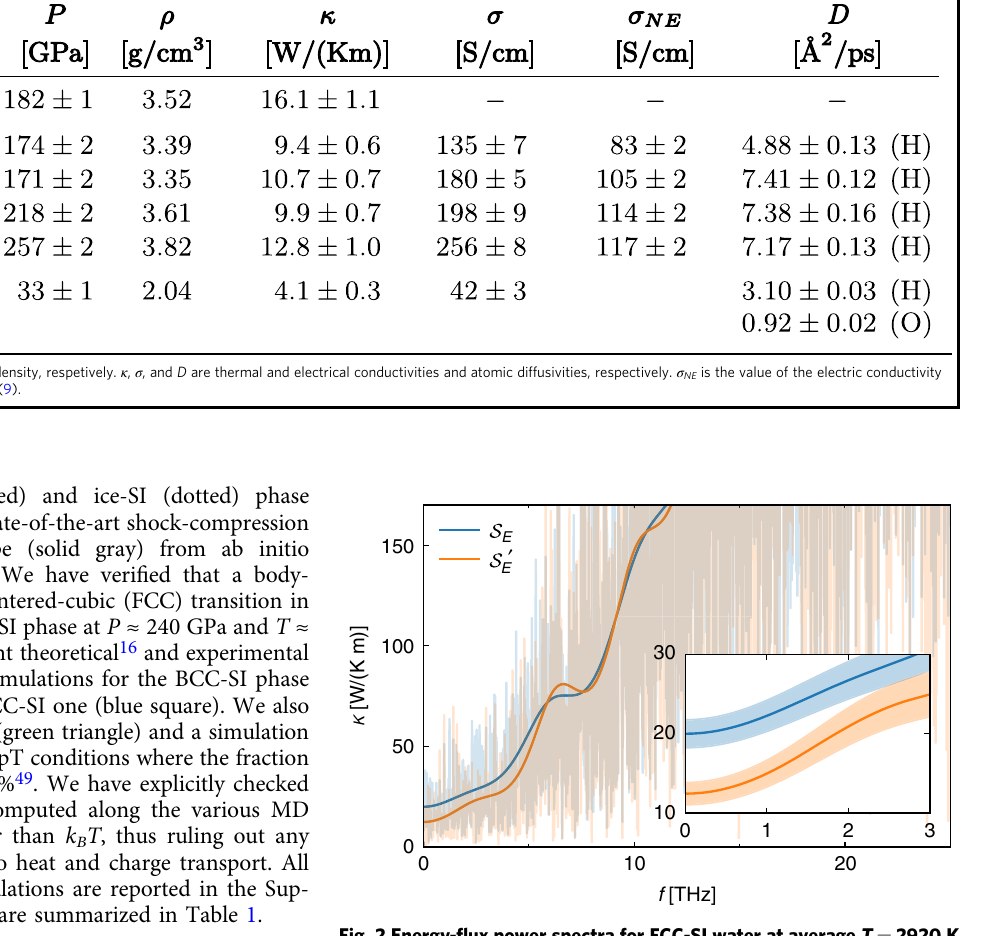
Fig. 2 Energy- fl ux power spectra for FCC-SI water at average T = 2920 K and P = 257 GPa. Blue: plain periodogram, S E . Orange: reduced periodogram, S 0 E , computed at vanishing mass fl uxes, Eq. (3). The thick lines are the fi ltered spectra obtained via cepstral analysis. Inset: low- frequency zoom of with their estimated